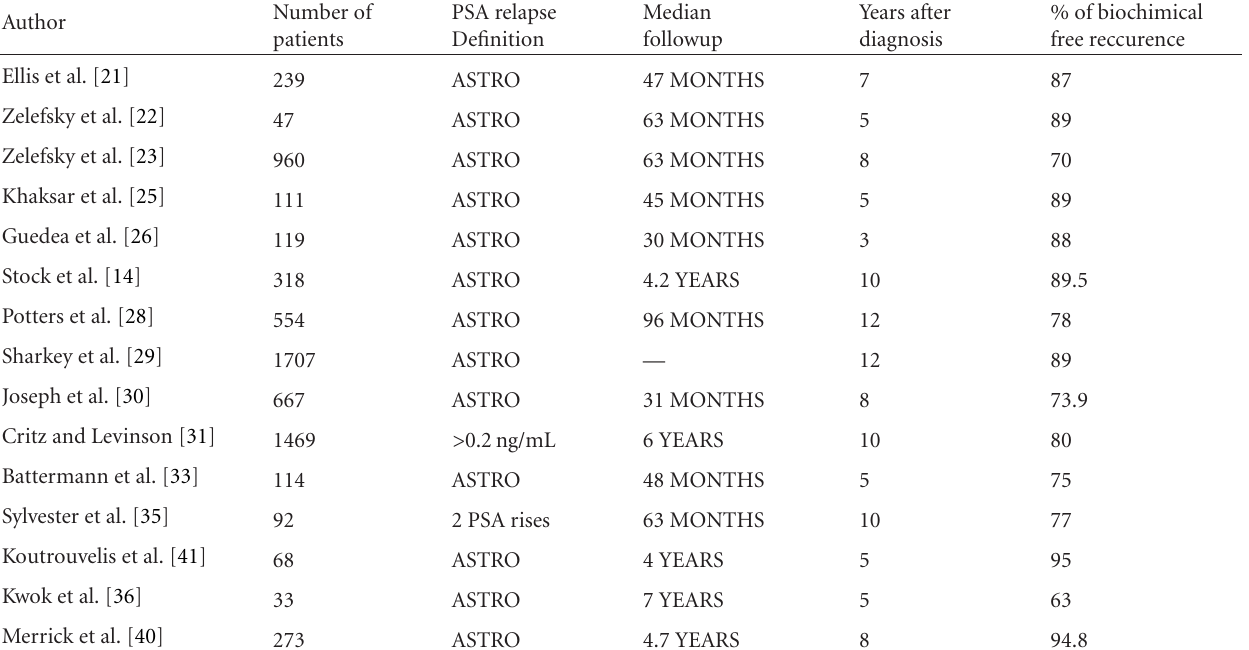
Table 2: LDR brachytherapy: clinical results for patients with intermediate-risk prostate